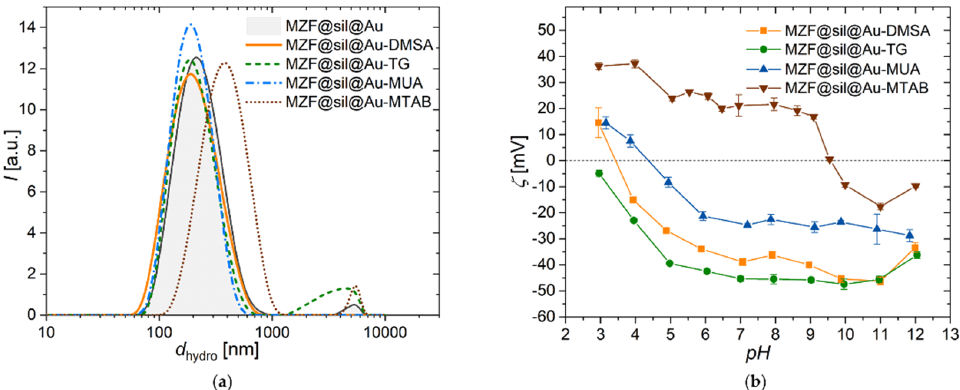
Figure 5. Dynamic and electrophoretic light scattering studies on gold nanoshells functionalized with four different model molecules (DMSA, TG, MUA, MTAB): ( a ) The intensity-weighted hydrodynamic size distribution of gold nanoshells functionalized with the four model compounds, measured on dilute aqueous suspensions by DLS; ( b ) dependence of zeta potential on pH measured by ELS; the error bars show 95% confidence intervals based on repeated measurements.